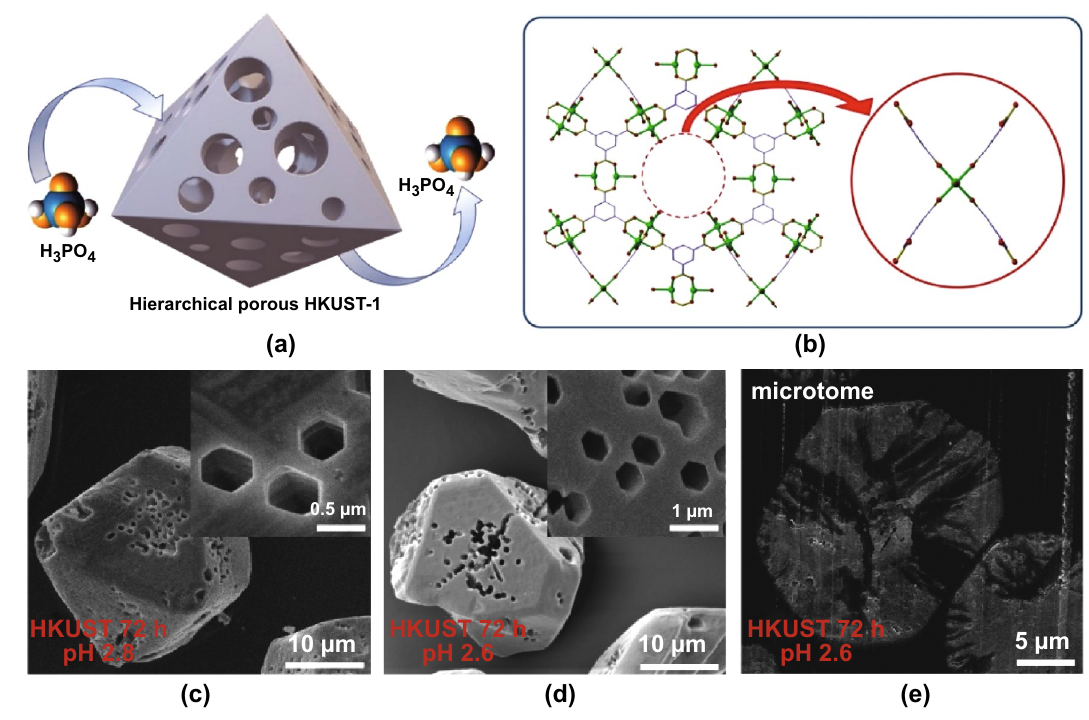
Fig. 13 a , b Schematic representation of the etching process for HKUST-1 using phosphoric acid, showing phosphoric acid diffusing into HKUST-1 to form a hierarchical porous structure (a) and the disassembly of a cluster and 4 linkers ( b ). c–e SEM images of HKUST-1 etching in phosphoric acid using DMSO and MeOH as dilute solvents at pH 2.8 ( c ) and pH 2.6 ( d, e ), showing interconnected geometrical macropores after etching. Reprinted with permission from Ref.